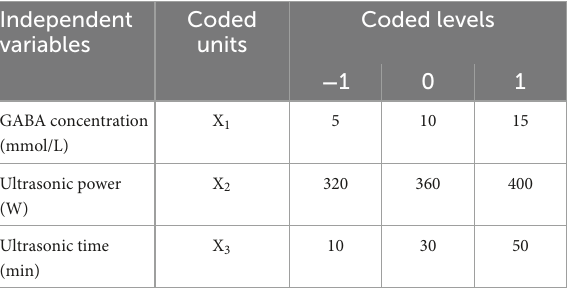
TABLE 1 Coded levels of independent